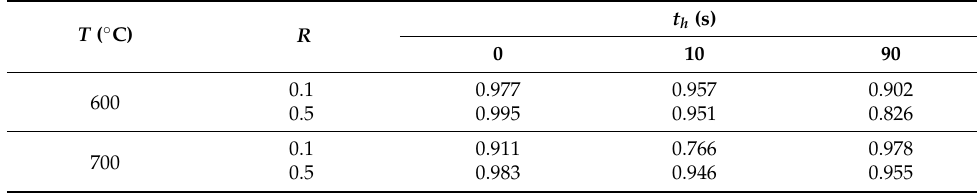
Table 8. Correlation coefficient between calculated and experimental d a /d N .